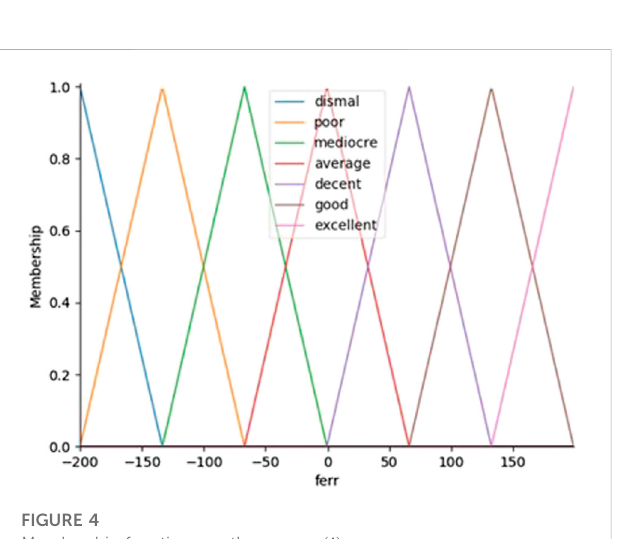
FIGURE 5 Membership functions vs. the output, u ( t )